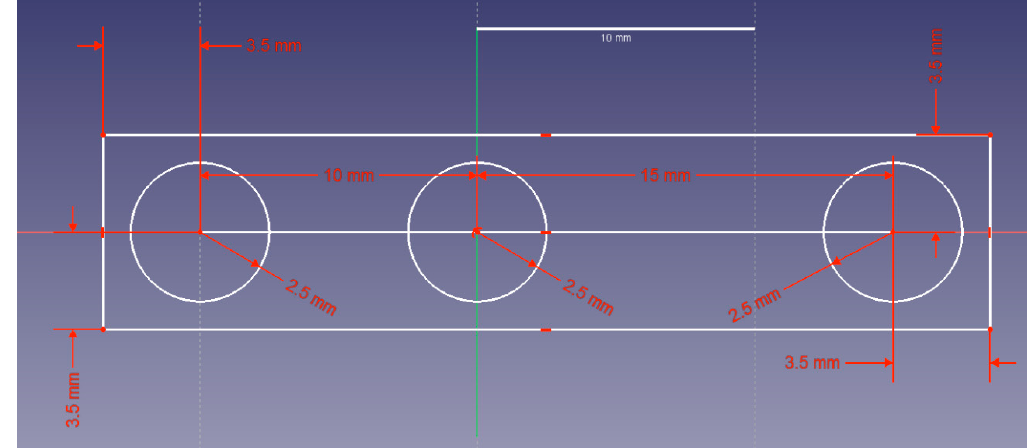
Figure 1. Drawing of the bearing surface for 5 mm pad diameter markers, the circles represent conductive material and are connected in 1 mm height.